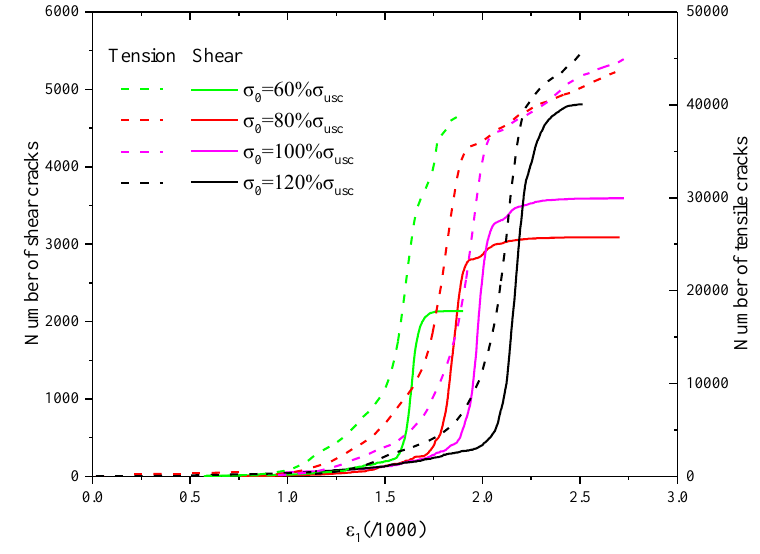
Figure 16. Influence of initial confining pressures on the number of microscopic cracks.